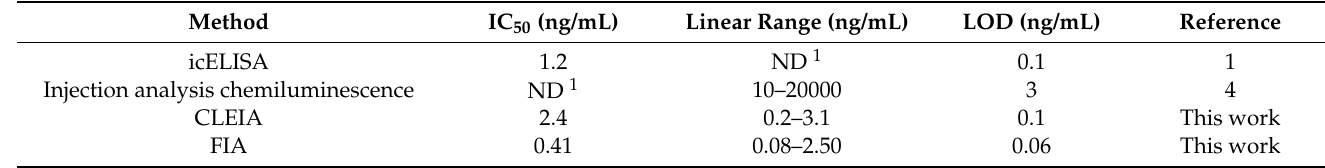
Table 3. The comparison of immunoassay for